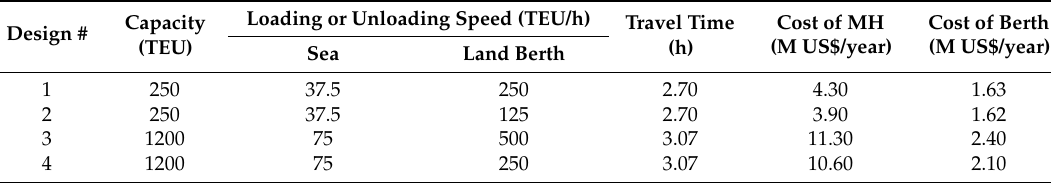
Table 2. Operation speed and cost of the